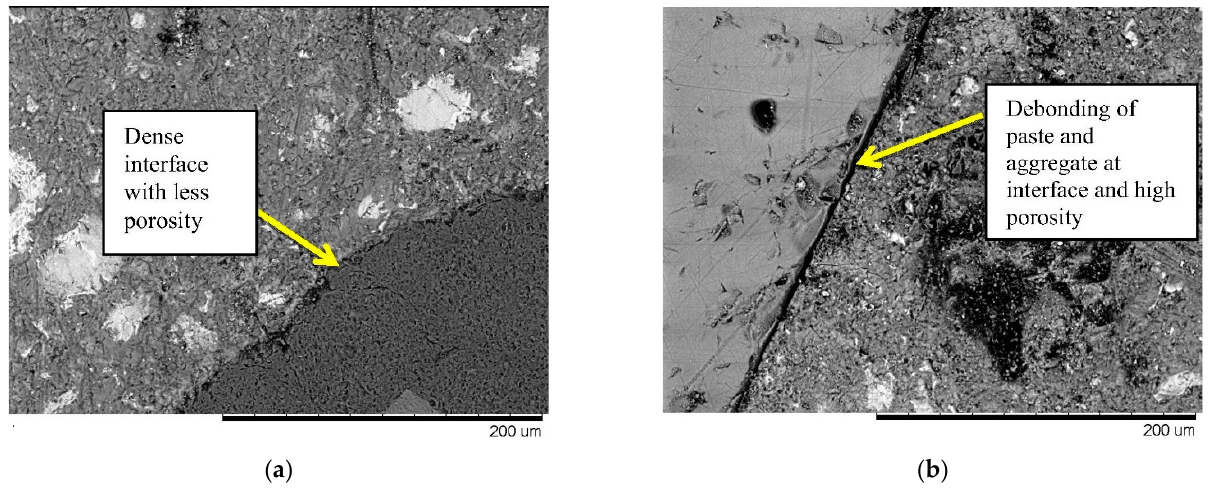
Figure 16. Microstructure of composites with: ( a ) natural aggregate; ( b ) waste glass aggregate (size: 4.75–9.5 mm) [105].